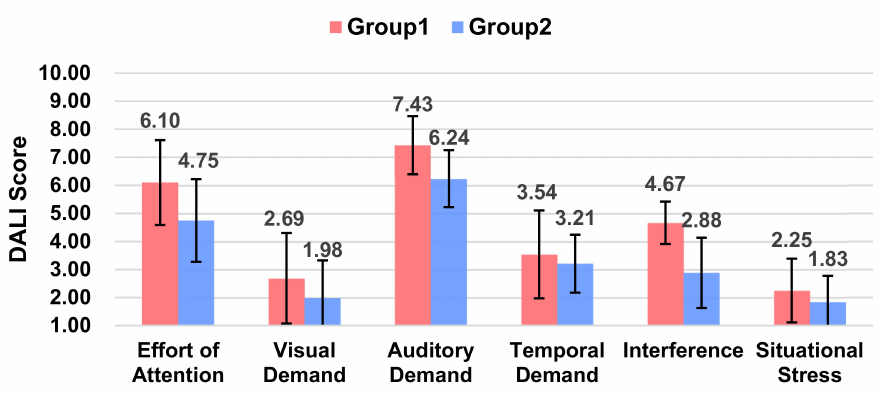
Figure 8. Ratings of Pleasure, Arousal, and Dominance between the two